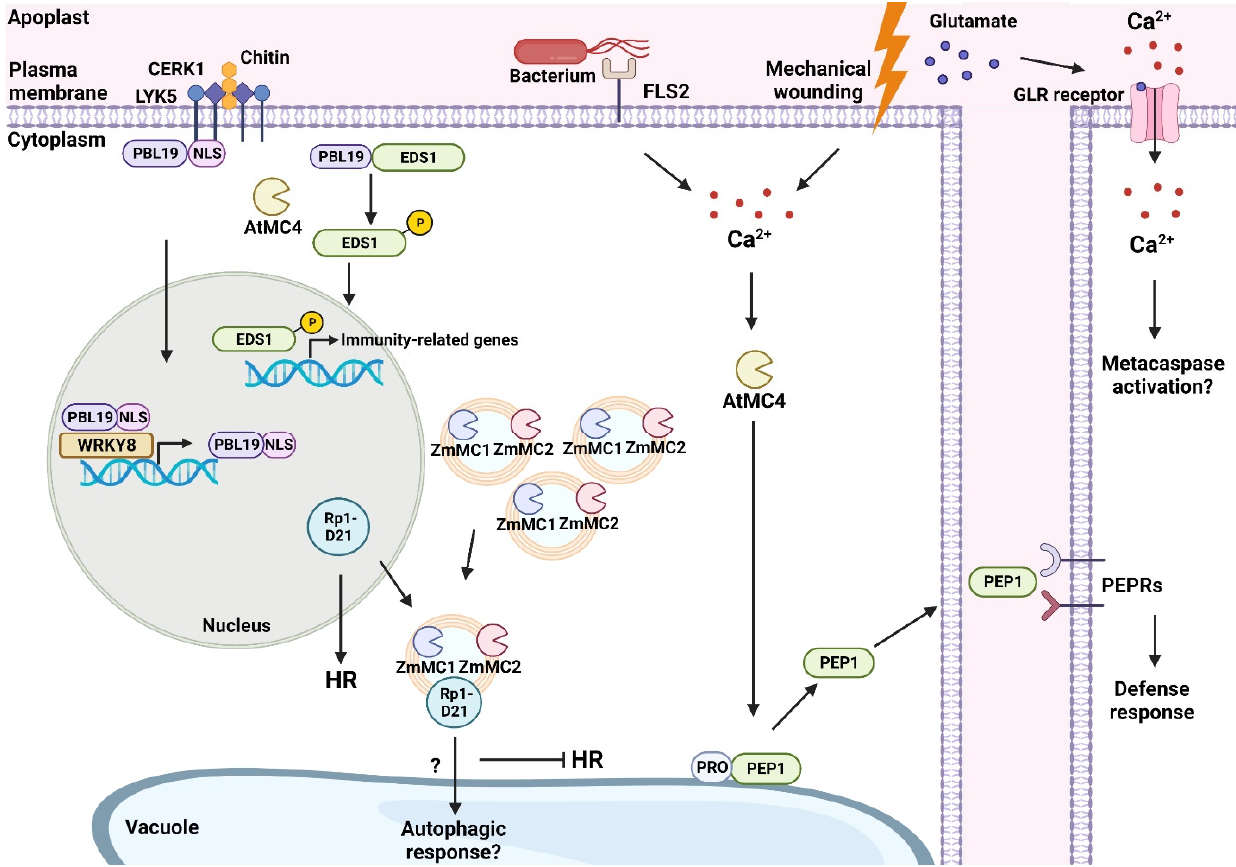
Figure 2. This working model depicts some plant metacaspases from A. thaliana and maize that are involved in promoting immune responses following physical damage or pathogen invasion. In A. thaliana , CERK1 (CHITIN ELICITOR RECEPTOR KINASE 1) and LYK5 (LYSM-CONTAINING RECEPTOR-LIKE KINASE 5) receptors triggered by chitin promote PBL19 (PBS1-LIKE 19) transloca- tion to the nucleus. In the nucleus, PBL19 can self-amplify using the WRKY8 transcription factor. The metacaspase AtMC4 cleaves the NLS (nuclear localization signal) of PBL19, causing an accumulation of PBL19 in the cytoplasm. Cytoplasm-localized PBL19 can phosphorylate EDS1 (ENHANCED DISEASE SUSCEPTIBILITY 1), which promotes the transcription of immunity-related genes once phosphorylated EDS1 enters the nucleus. Mechanical wounding or bacterial flagellum activating FLS2 (flagellin sensing 2 receptor) causes an influx of Ca 2+ inside the cytoplasm. This accumulation of Ca 2+ activates AtMC4 which can process PROPEP1 into PEP1 and alter its localization from the tonoplast to the cytoplasm. PEP1 can then bind to PEPRs located at the plasma membrane of healthy cells to activate defense responses in neighboring cells. Mechanical wounding in A. thaliana has been shown to promote glutamate-based long-distance signaling to neighboring, undamaged cells. Glutamate binds to GLR (glutamate-like receptor) proteins that open and facilitate an influx of Ca 2+ and may promote further metacaspase activation. In maize, metacaspases ZmMC1/2 follow a punctate localization in autophagosomes. The NLR protein, Rp1-D21, resides in the nucleus and can promote HR in maize. The interaction between ZmMC1/2 and Rp1-D21 causes Rp1-D21 to translocate from the nucleus to autophagosomes. The potential degradation of Rp1-D21 causes a sequestering of HR. Created on BioRender.com on 6 December